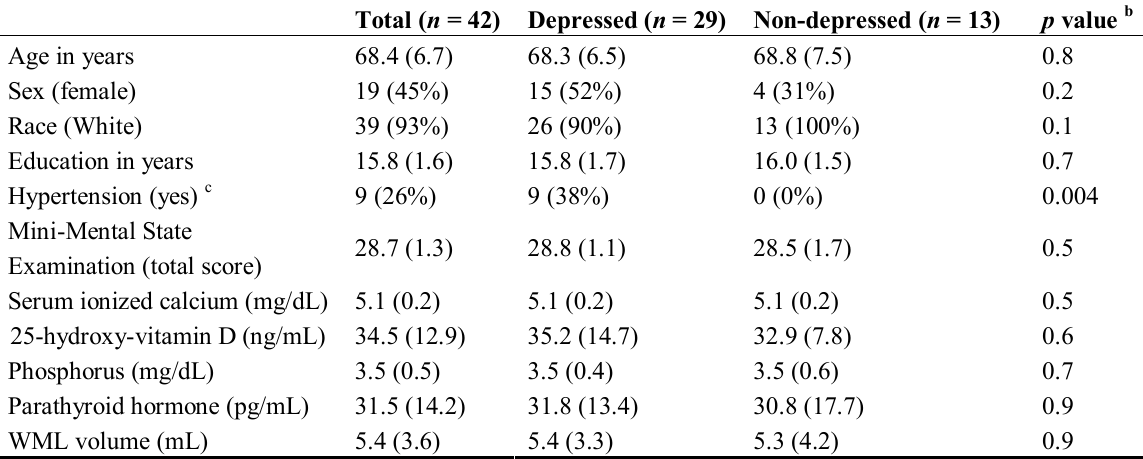
Table 1. Participant characteristics: Sociodemographics, hypertension, lab values, and white matter lesions (WMLs) a